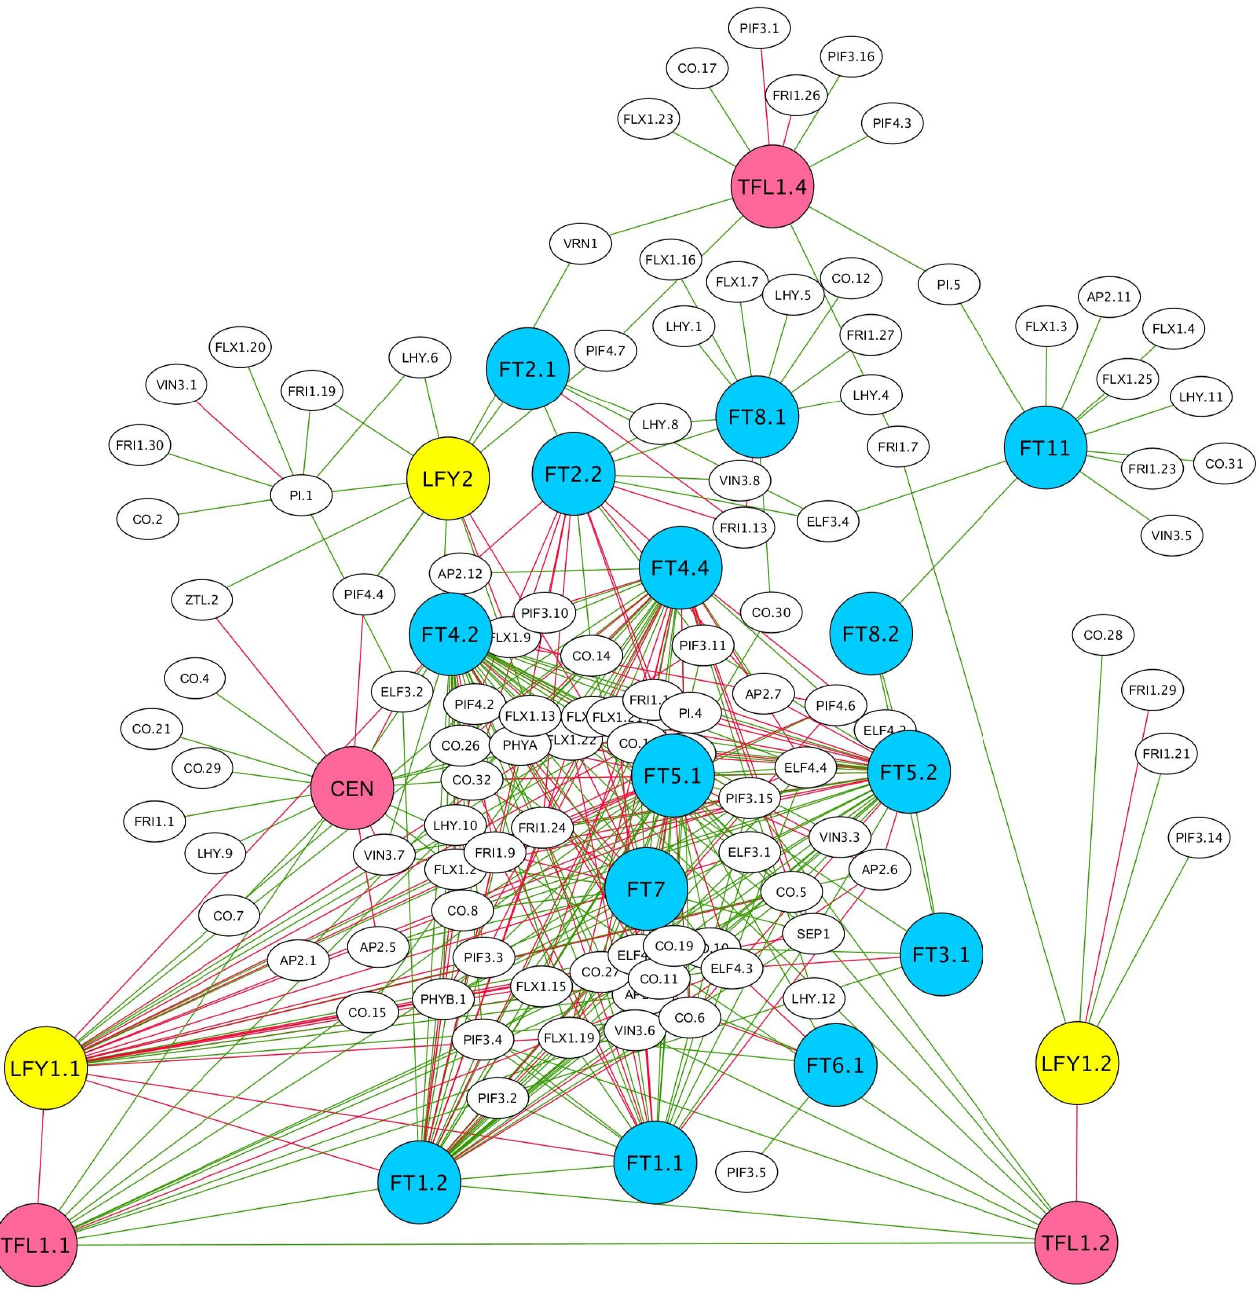
Figure 3. Gene co-expression network (GCN) representation of garlic genes associated with floral transition. Transcriptome data are from the stages of meristem transition and flower differentiation. Transcript sequences were mapped to the garlic genome and analyzed using the network-drawing software Cytoscape. Pearson correlation value higher than 0.75. Positive (green lines) and negative (red lines) correlations between FT -like (blue), TFL1/CEN -like (pink), LFY -like (yellow), and other genes involved in florogenesis are